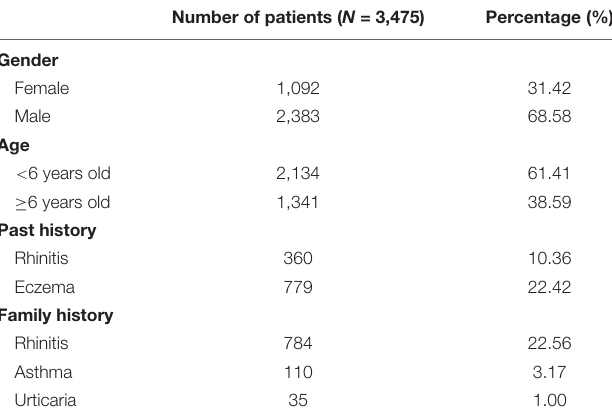
TABLE 2 | Characteristics of the study